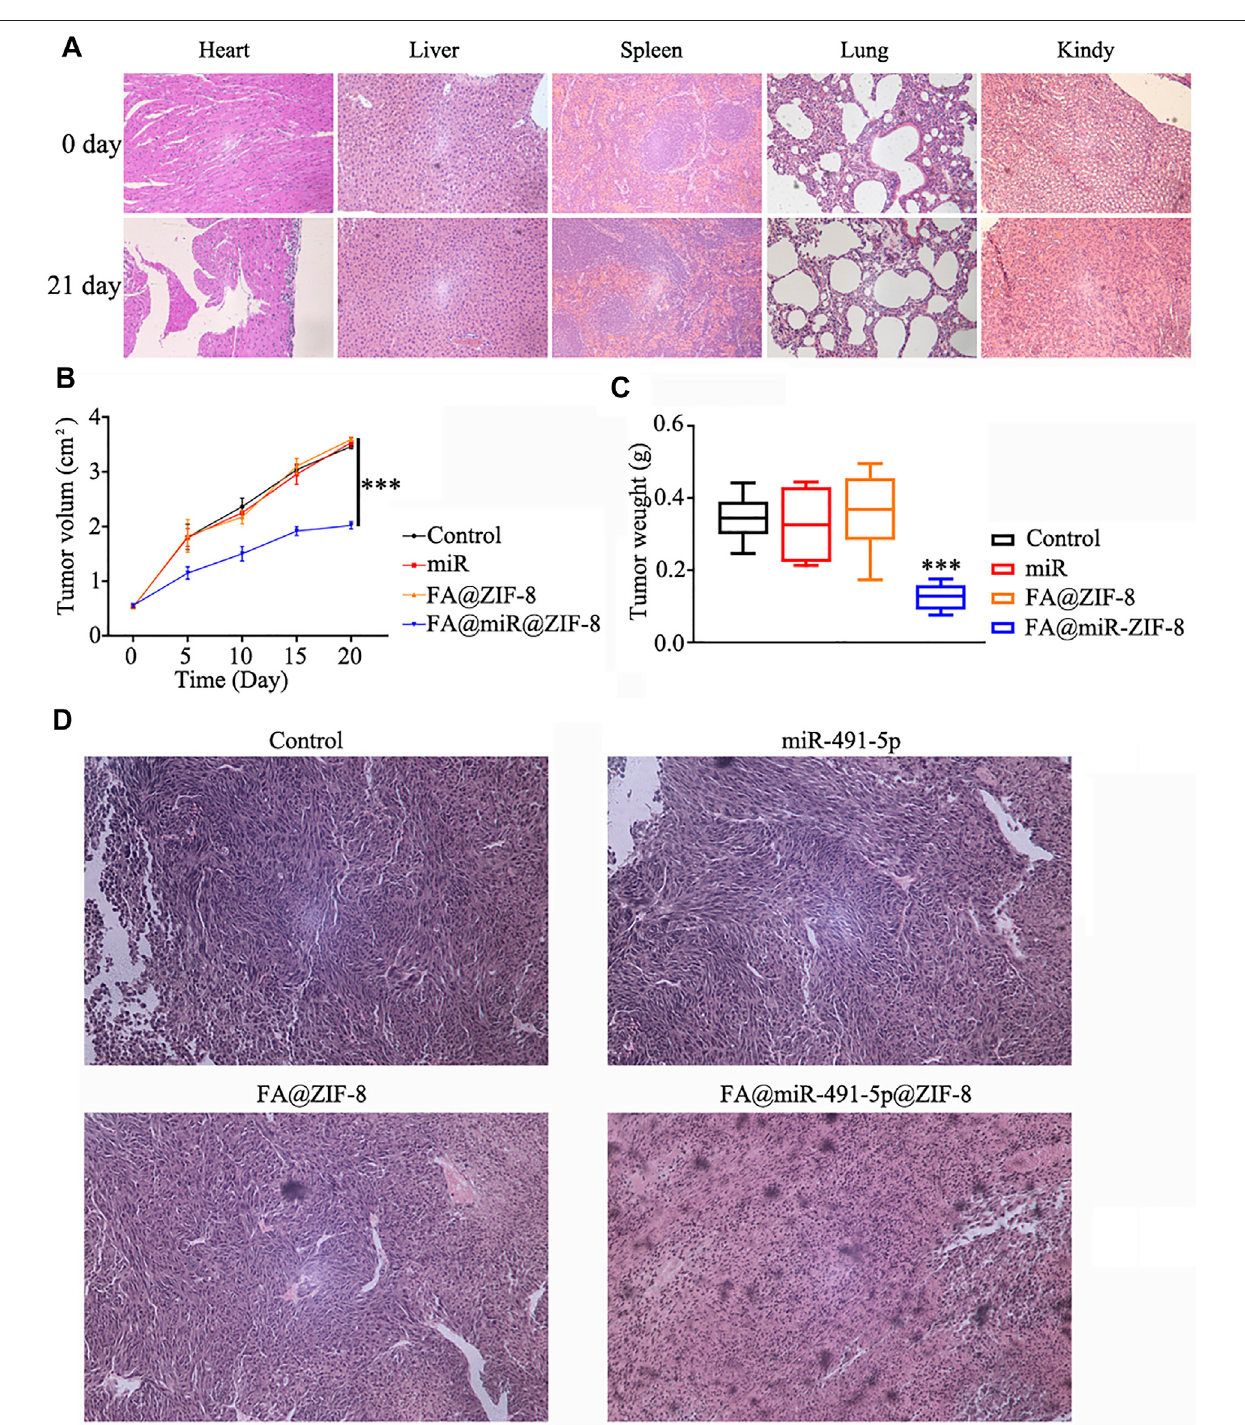
FIGURE6| FA@miR-491-5p@ZIF-8 signi fi cantlyinhibitedproliferation insolidCRPC tumors. (A) Acute toxicityofFA@ZIF-8inmice wasdeterminedbyusing anH & E staining assay to observe the effects of FA@ZIF-8 on the mouse heart, liver, spleen, lungs, and kidneys. (B) FA@miR-491-5p@ZIF-8 reduced the tumor volume in mice. (C) FA@miR-491-5p@ZIF-8 reduced tumor weight. ( D ) H&E staining assay showed that FA@miR-491-5p@ZIF-8 caused a signi fi cant degree of damage to tumor tissues. Data are expressed as the mean ± SD (* p < 0.05, ** p < 0.01, and *** p < 0.001).